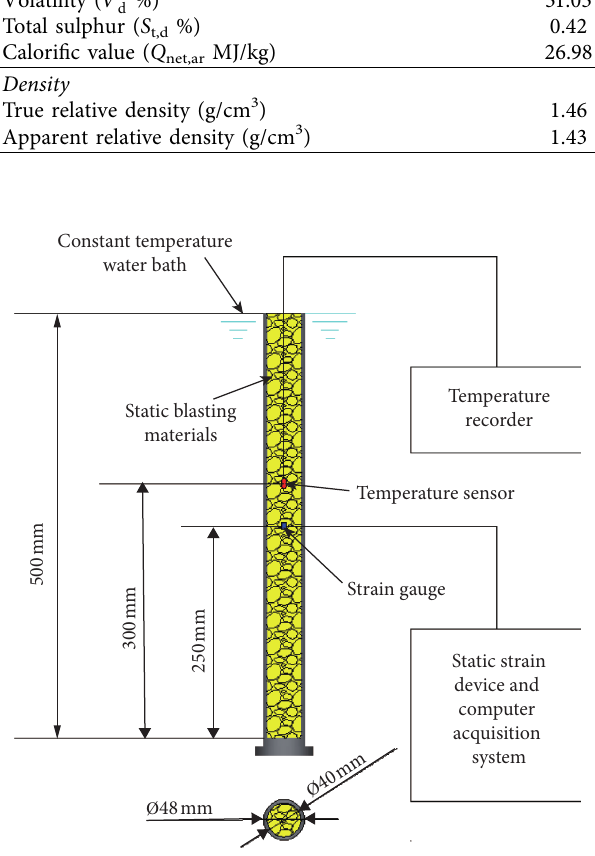
Figure 2: Measurement principle of reaction temperature and expansion pressure of static blasting materials.